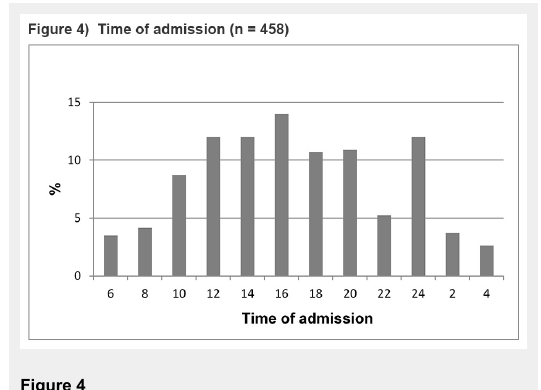
Distribution of admissions over the day (n =